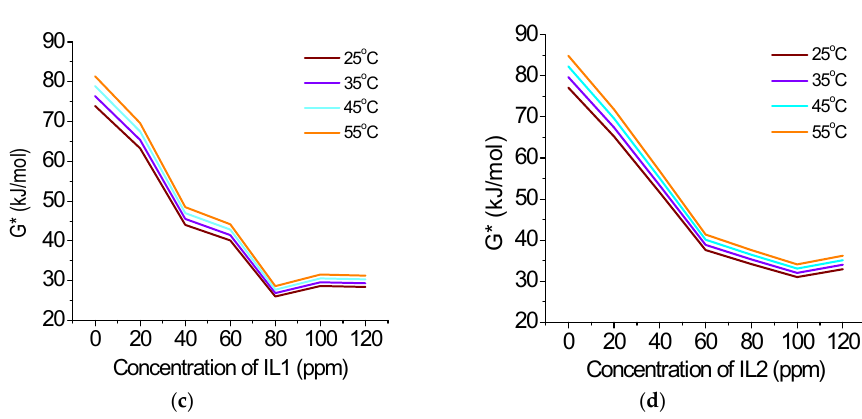
Figure 6. Graphs of the correlation between ln(I corr / T) towards 1000 / T in the corrosion system after the addition of IL1 ( a ) and IL2 ( b ); ( c ) and ( d ) represent the free energy values ΔG* of the corrosion system after the addition of IL1 and IL2 at various temperatures, respectively. Table 6. Thermodynamic parameters of IL1 and IL2 as corrosion inhibitors on carbon steel surface in 1% NaCl.